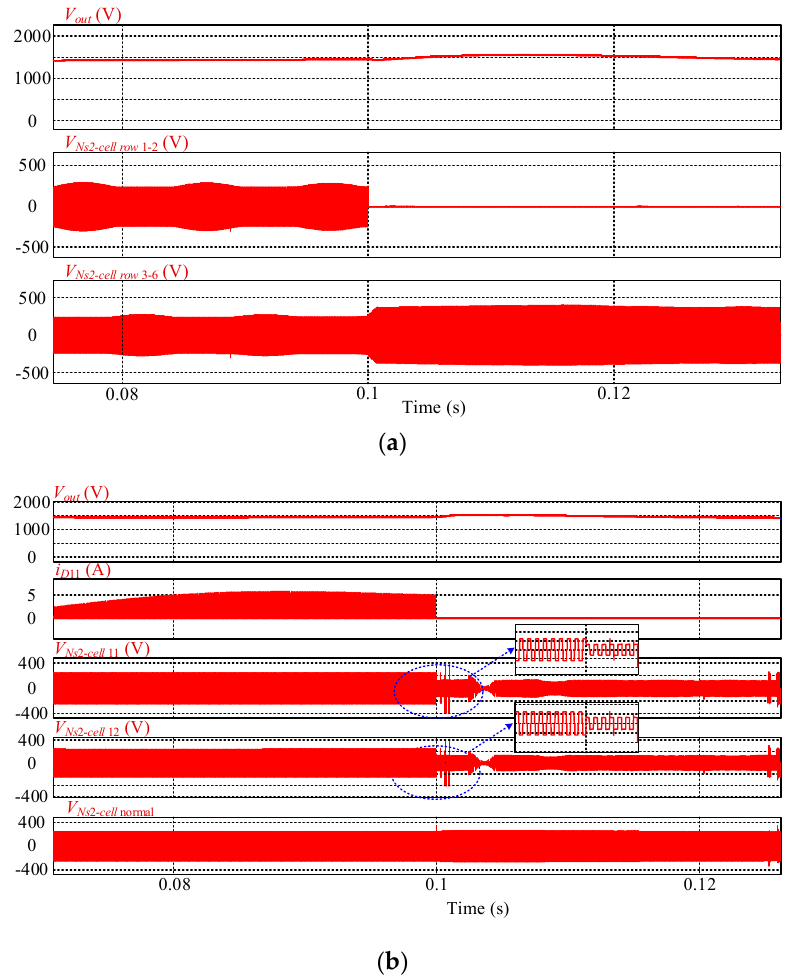
Figure 18. Fault tolerance operation without redundancy: ( a ) Without redundancy for D 11 short-circuit; ( b ) Without redundancy for D 11 open-circuit.